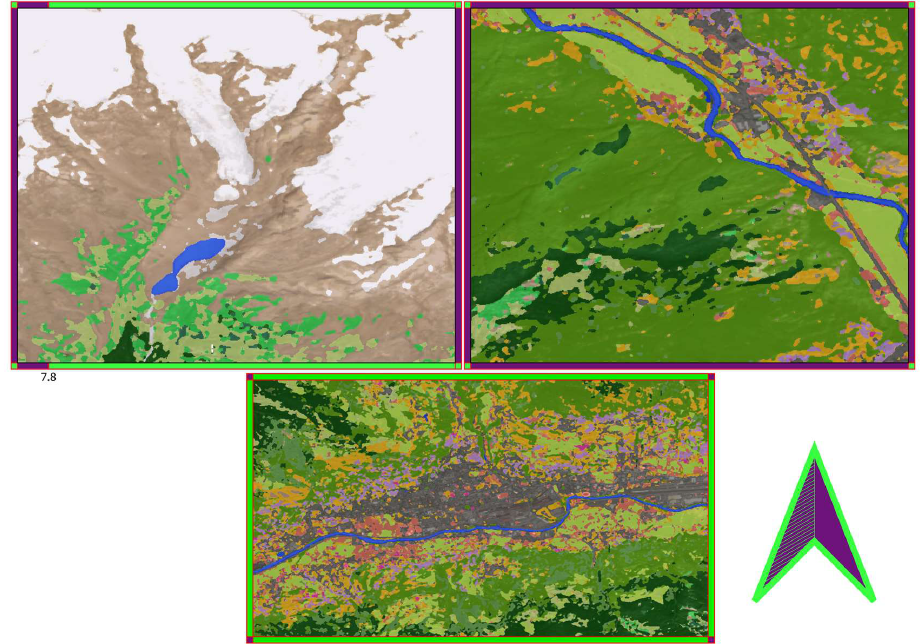
Figure 6. Samples images of classified areas with a high satellite resolution images on the back- ground.